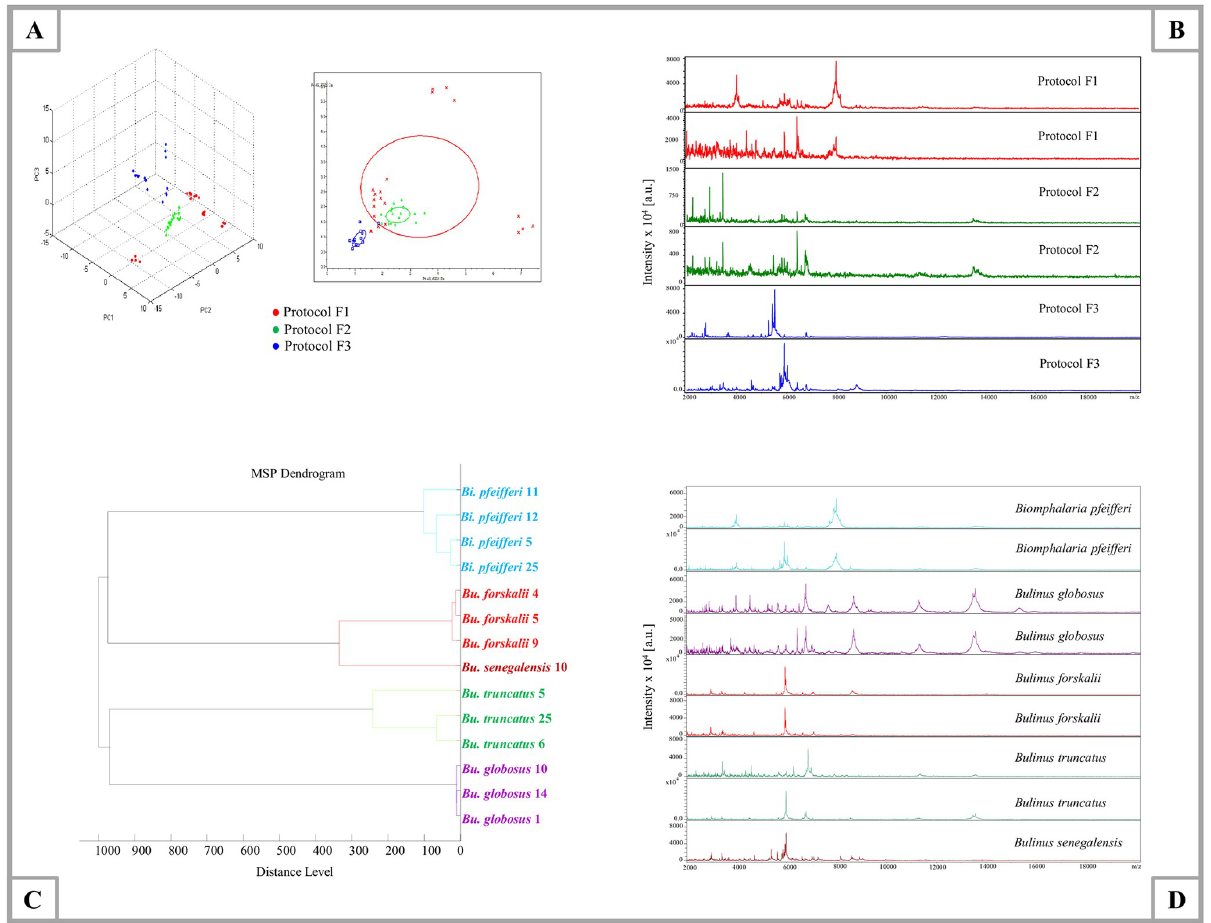
Fig 5. Comparison of MALDI-TOF MS spectra from the foot of ethanol-stored specimens. (A) Comparison of MALDI-TOF MS spectra of three different protocols on principal component analysis using ClinProTools v.2.2; protocol F1 (30 μ l Mix+ glass beads), protocol F2 (30 μ l Mix+ tungsten beads), and protocol F3 (15 μ l Mix+ glass beads). (B) Representative MS spectra of Bi . pfeifferi obtained for each protocol, analysed by Flex analysis. (C) Hierarchical clustering dendrogram of Bi . pfeifferi , Bu . truncatus , Bu . globosus , Bu . forskalii , and Bu . senegalensis performed by Biotyper software v.3.0. (D) Representative MALDI-TOF MS profiles of Bi . pfeifferi , Bu . truncatus , Bu . globosus , Bu . forskalii and Bu . senegalensis using protocol F3, performed using Flex Analysis Software. a.u.: arbitrary units; m / z : mass-to-charge ratio. The x-axis represents PC1 and the y-axis represents PC2.